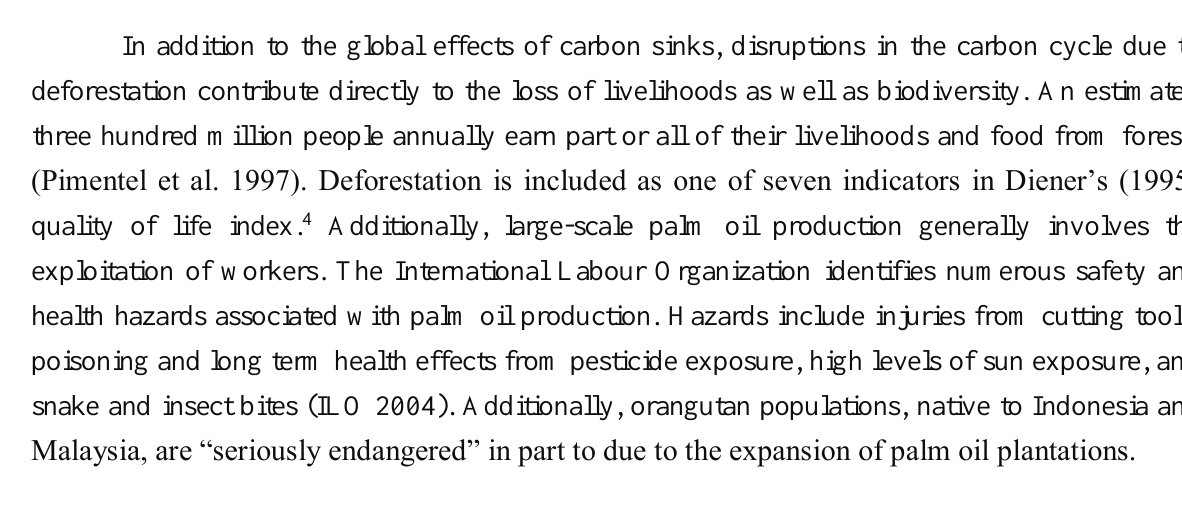
Figure 1. Palm Oil Production in Indonesia and Malaysia, 1990 –